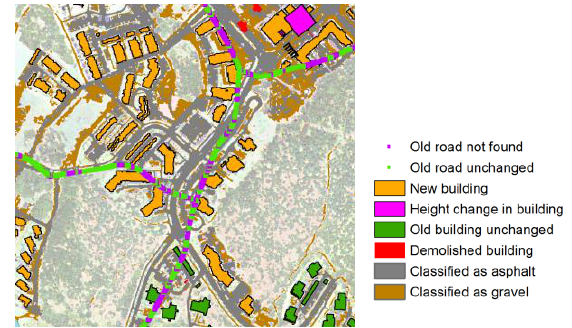
Figure 3. Change detection results for buildings and roads overlaid on the Titan intensity image in a new residential area. Original map data for old buildings © the City of Espoo. Original map data for old roads is based on the NLS Topographic Database 2000.